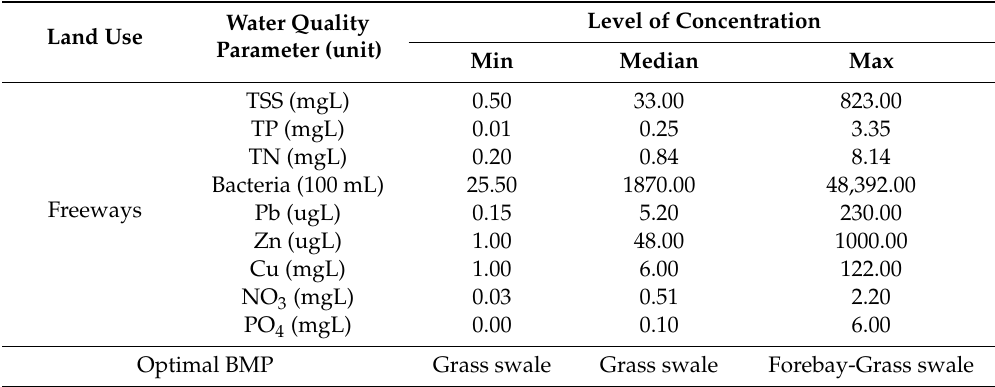
Table 7. BMP selection by land use (freeways) and pollutant concentration.